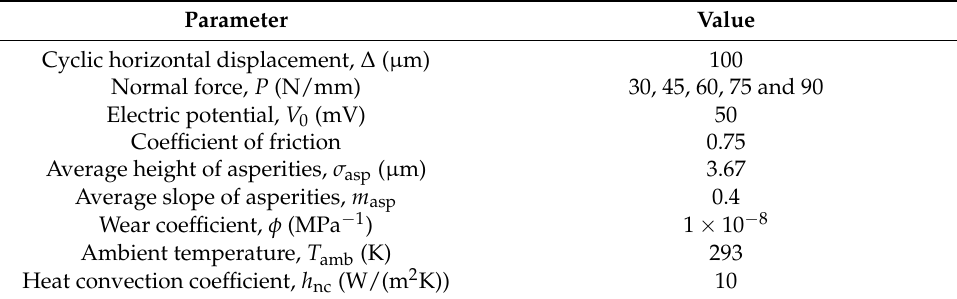
Table 2. Parameters in the modeling of electrical contacts.